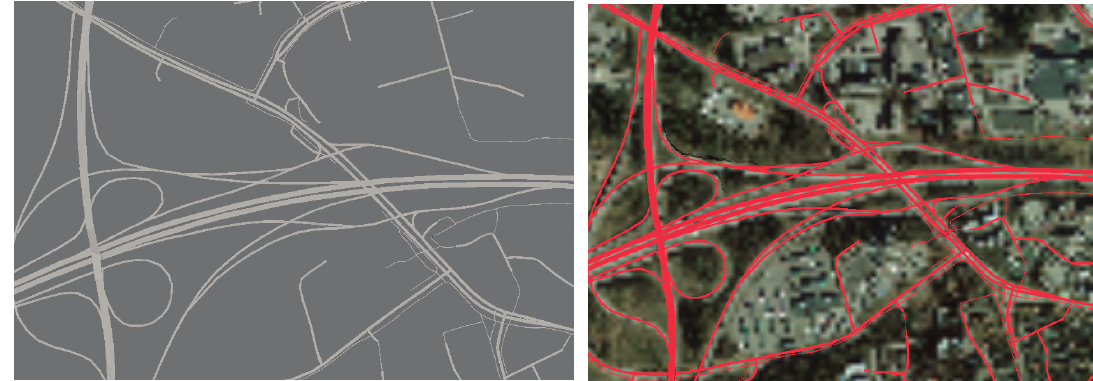
Figure 25. Road detection and reconstruction from a 2D topographic database and ALS. ( Left ) red lines are the central lines of the carriageways from topographic database. Others are ALS point cloud; ( Right ) detected road points overlaid with meshed terrain (dark blue).